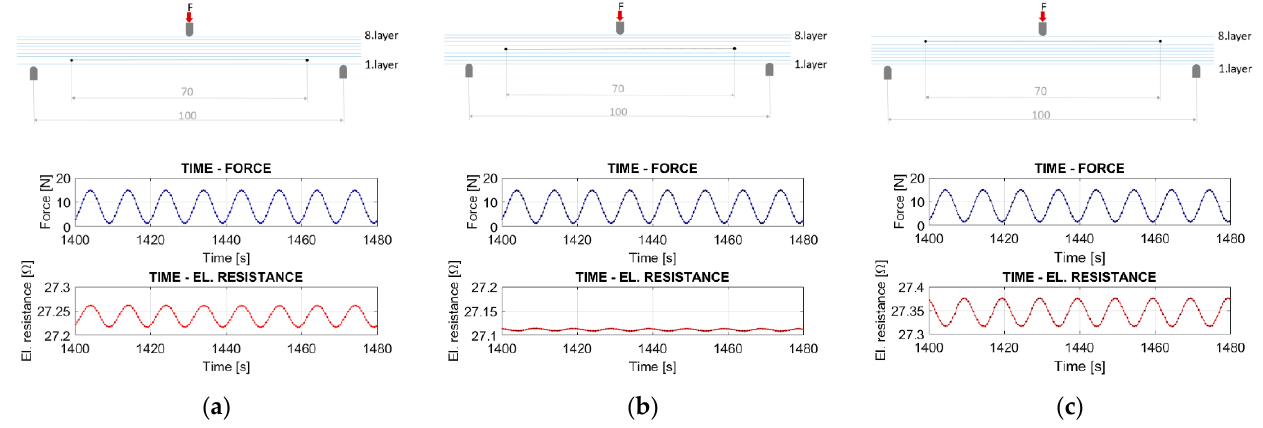
Figure 8. Configuration of the 3PB test and the measured signal from the integrated CFSs: ( a ) results for specimen with CFS between the 1st and 2nd layer during 3PB (measured data of T300-30), ( b ) results for specimen with CFS between the 4th and 5th layer during 3PB (measured data of T300-37), ( c ) results for specimen with CFS between the 7th and 8th layer during 3PB (measured data of T300-16).